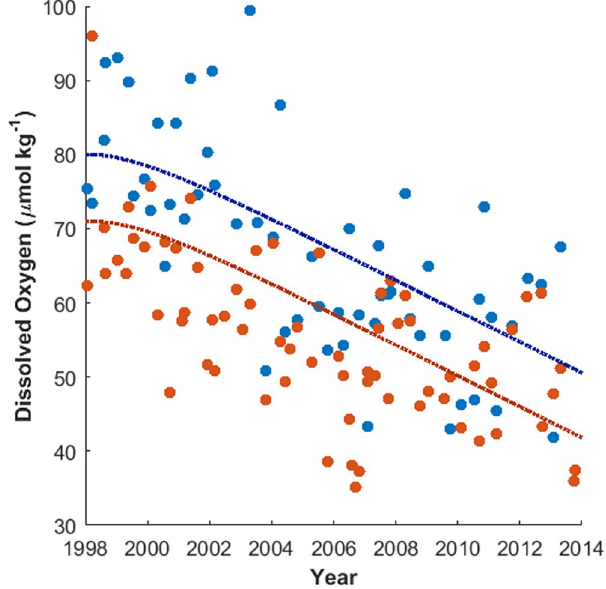
Figure 5. Inshore (average of stations 55–65, orange circles) and offshore (average of stations 75–85, blue circles) dissolved oxygen from Line 67 observations over time along σ θ = 26.7 kg m − 3 . Box model dissolved oxygen over the first 16 years of simulation are plotted for the inshore (orange line) and offshore (blue line) boxes. The simulation used annual decline in northern and southern source water dissolved oxygen of 2.08 µ mol kg − 1 year − 1 . Linear rates of decline over the time period in the box model are 1.94 µ mol kg − 1 year − 1 and 1.92 µ mol kg − 1 year − 1 for the inshore box and offshore box